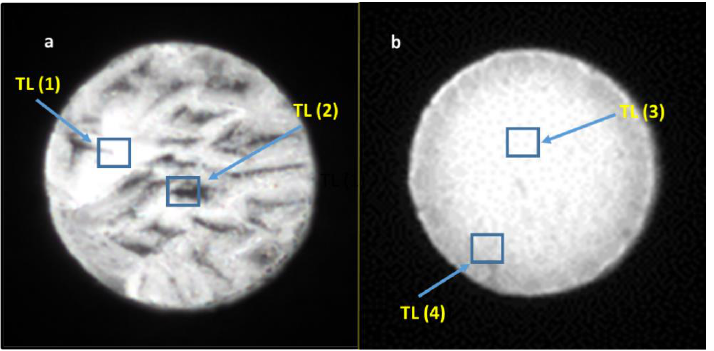
Figure 7. Images of luminous surfaces of samples No. 3 ( a ) and No. 12 ( b ) cut out from the LMP crystal doped with 0.8-mol% Tb. The images were recorded in a reader with a CCD camera after samples were irradiated with 20 Gy of beta rays.